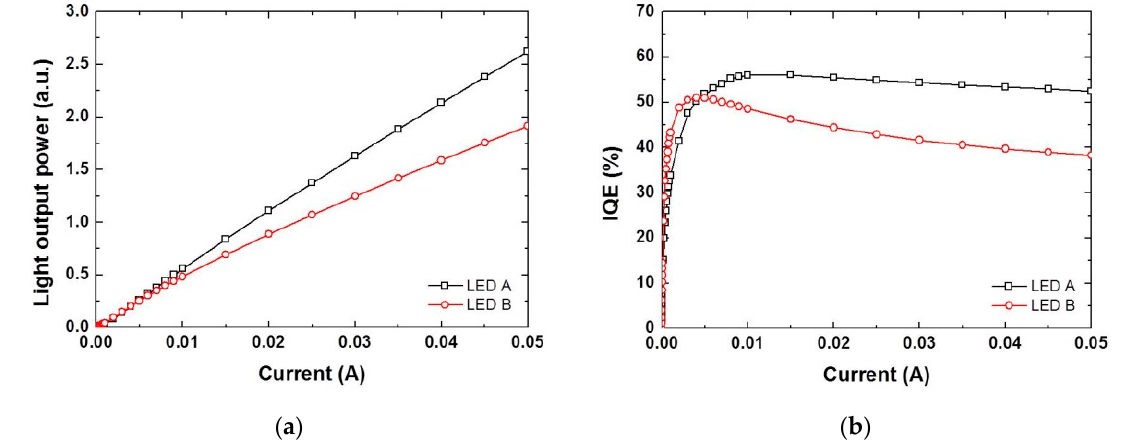
Figure 5. Results of ( a ) light output power-current characteristics (L–I curve) and ( b ) internal quantum efficiency-current characteristics (IQE–I curve) for LED A and LED B on a linear scale.